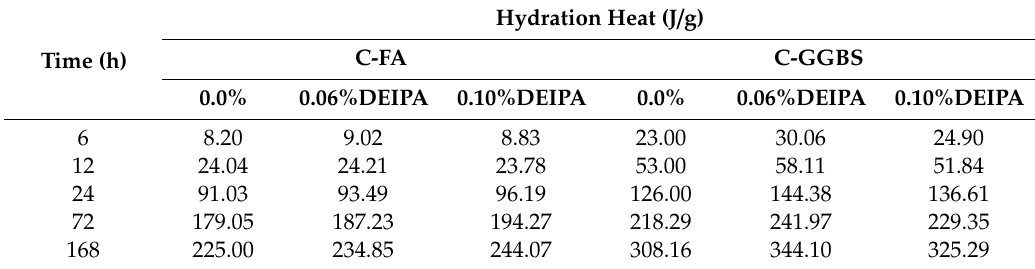
Figure 4. Hydration heat of the paste with DEIPA, ( a ) heat flow, ( b ) hydration heat. Table 3. Hydration heat within 7 d age.